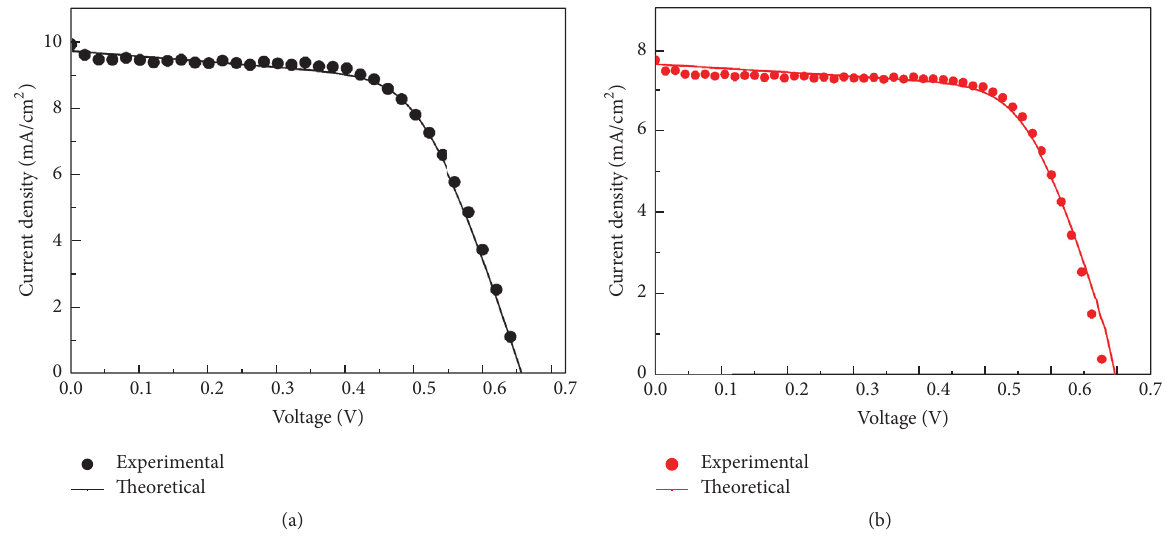
Figure 8: Experimental and theoretical fit for J-V characteristics of (a) fresh and (b) degraded DSC,